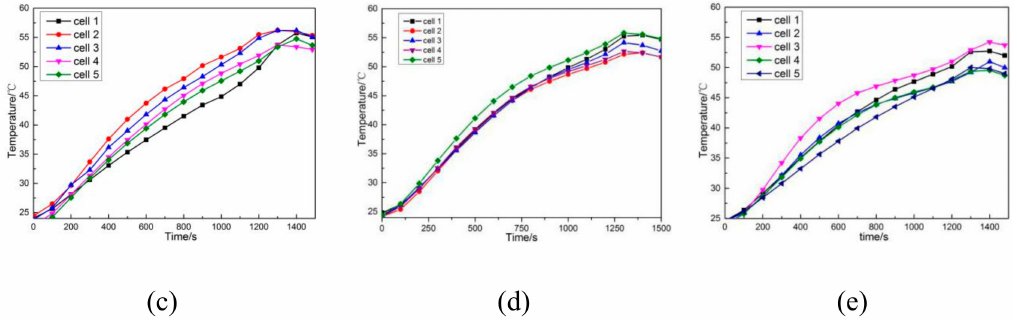
Figure 9. Surface temperature curve of the battery under di ff erent EG content of 2.5C discharge rate: ( a ) 0% EG; ( b ) 5% EG; ( c ) 10% EG; ( d ) 15% EG; ( e ) 20% EG.